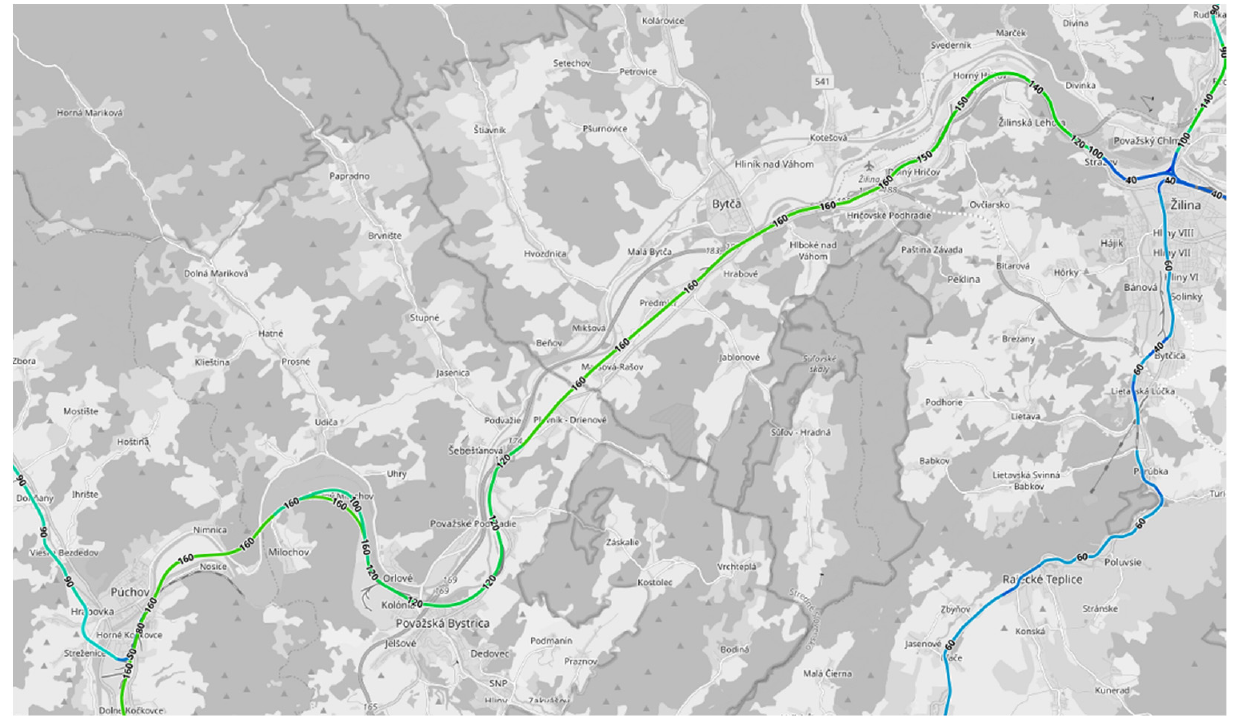
Figure 3. Track section Žilina—Púchov with speed limitations.